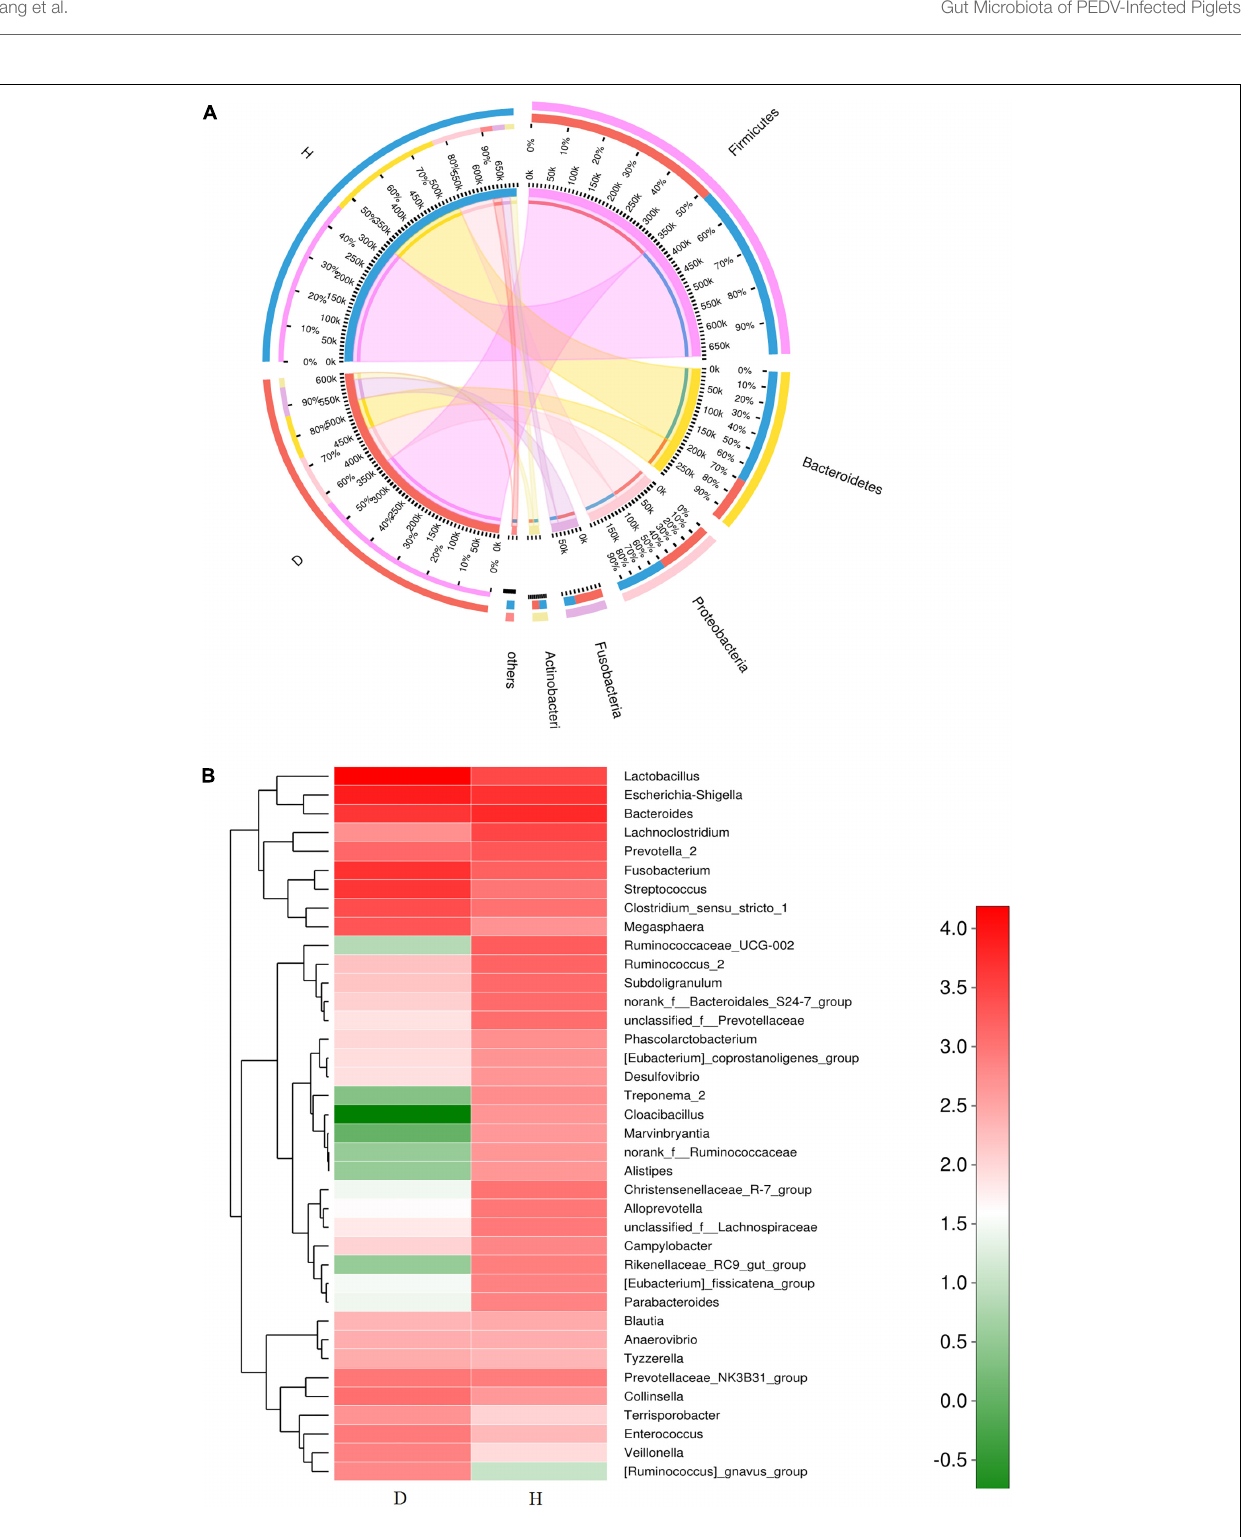
Frontiers in Microbiology |